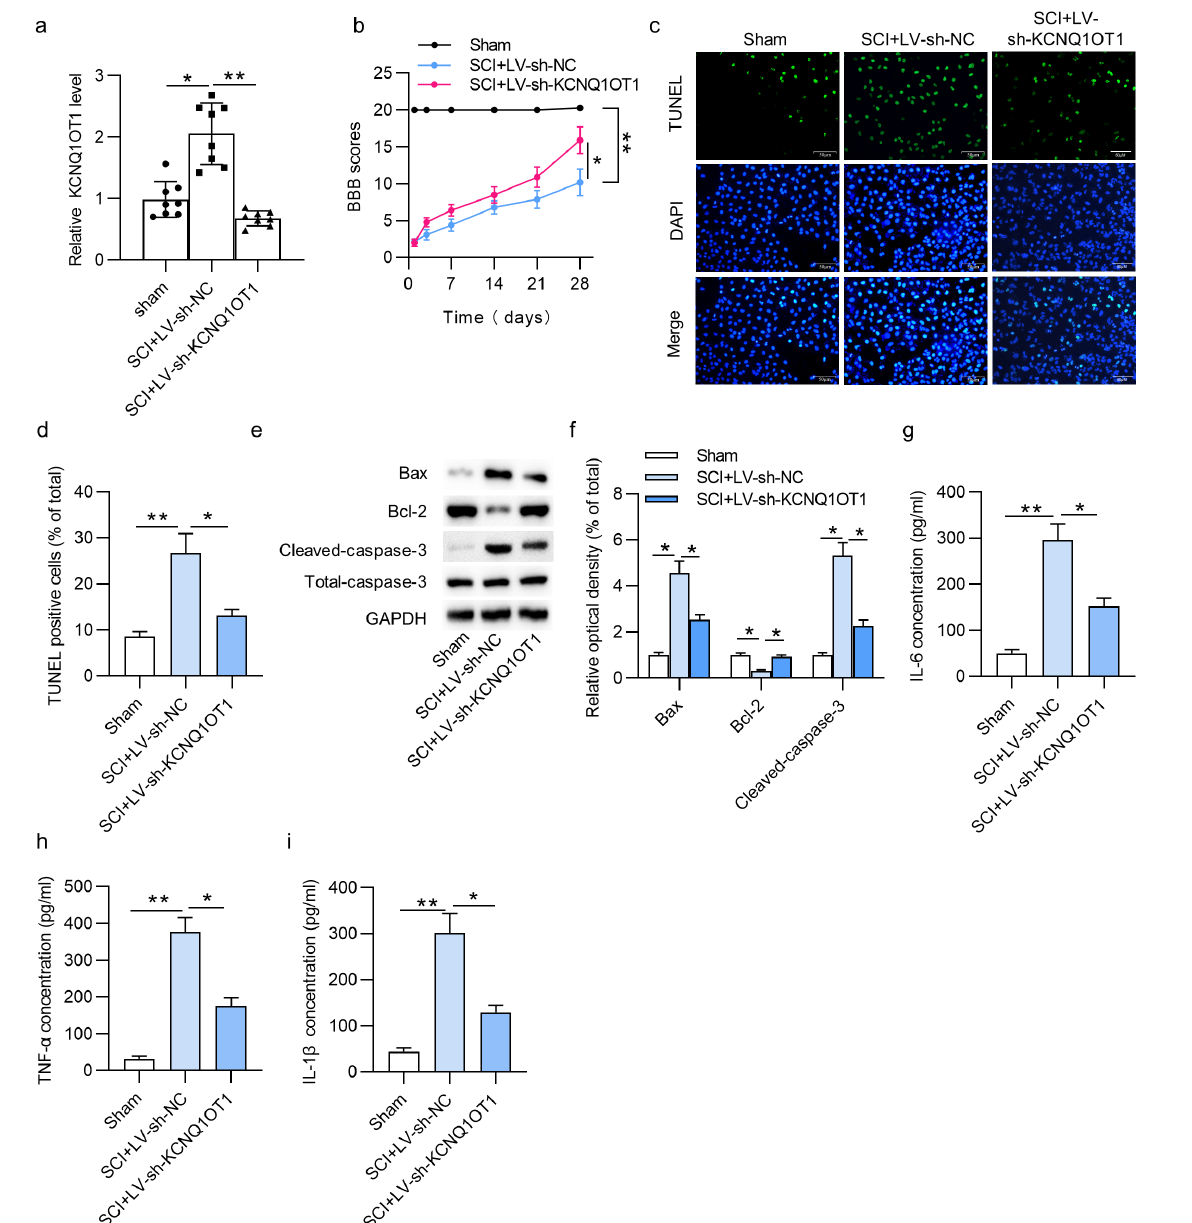
Figure 2. Silencing of KCNQ1OT1 alleviated apoptosis of microglia and inflammatory response. (a) RT-qPCR analysis was carried out to detect KCNQ1OT1 level after injection of LV-shRNA targeting KCNQ1OT1 into mice. (b) BBB scores showed the behavioral analyses of the mice. (c-d) TUNEL staining was used to test the number of TUNEL positive cells in different groups. (e-f) The protein levels of Bax, Bcl-2 and Cleaved-caspase-3 in different groups were determined by western blot analysis. (g-i) ELISA was used to measure the concentrations of IL-6, TNF-α and IL-1β in different groups. N=8 in each group. * p < 0.05. ** p <